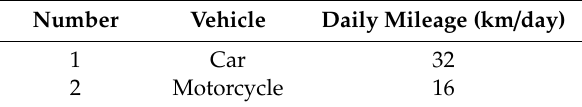
Table 2. Daily travelling mileage.